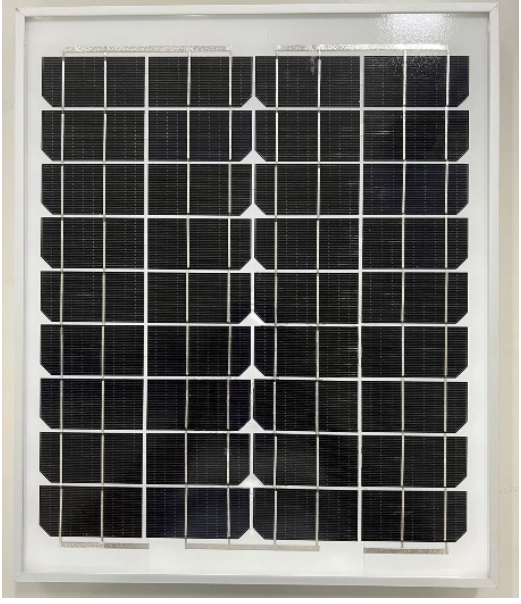
Figure 3. Normal PV module .